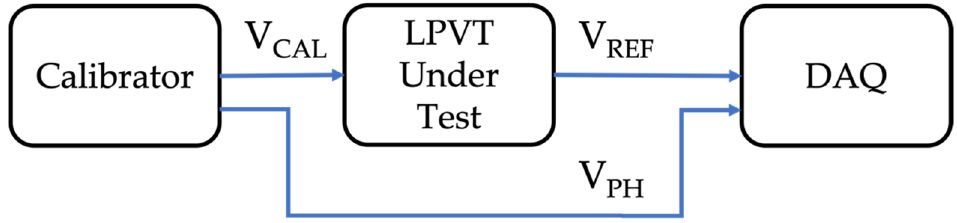
Figure 4. Measurement setup adopted for the reference